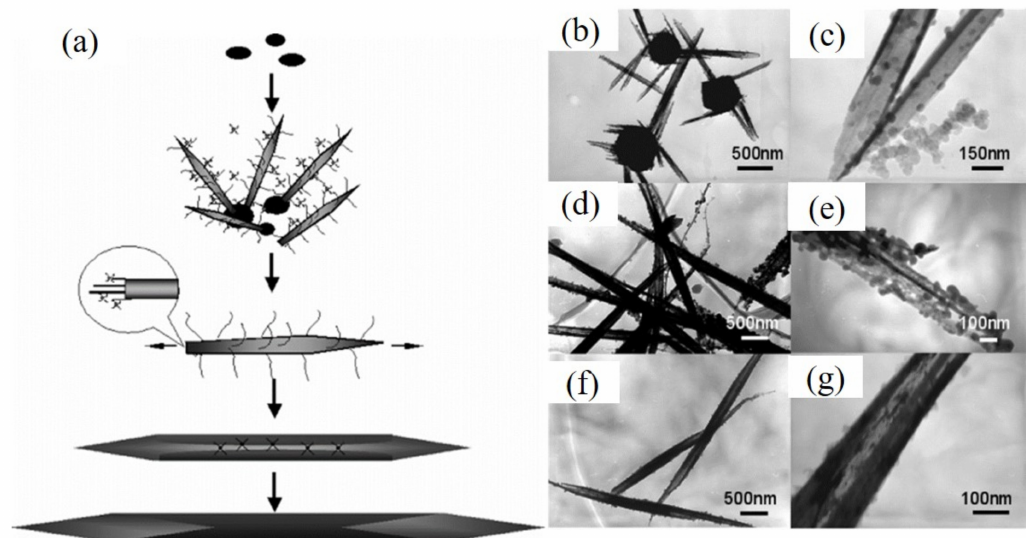
Figure 8. ( a ) The SG mechanism for the formation of shuttle-like Te NTs using serine as additive. ( b – g ) TEM images of Te NTs obtained at different stages: ( b ) and ( c ) 2 h, ( d ) and ( e ) 4 h, ( f ) and ( g ) 12 h. Reprinted with permission from [12]. Copyright 2005, American Chemical Society, Washington, DC, United